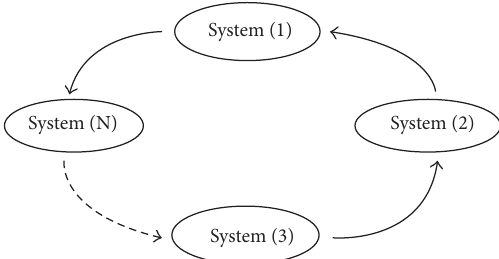
Figure 1: Diagram of coupled complex chaotic systems with ring